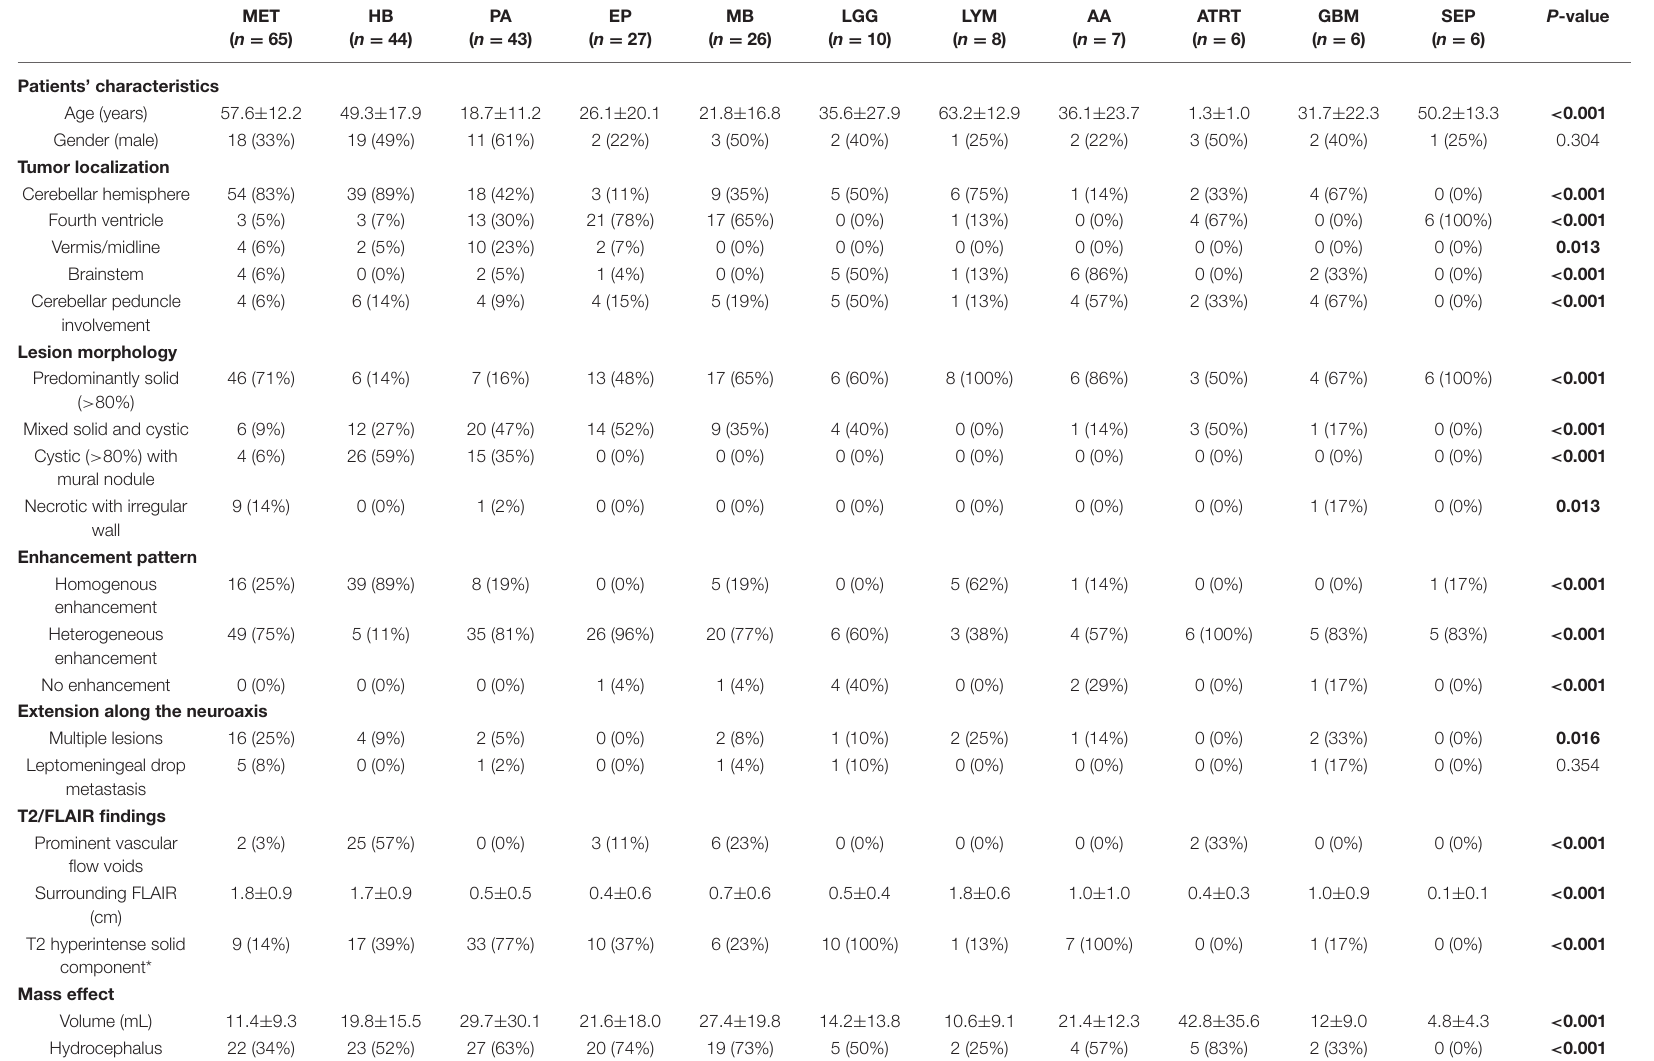
TABLE 2 | Structural MRI findings and clinical characteristics among various posterior fossa